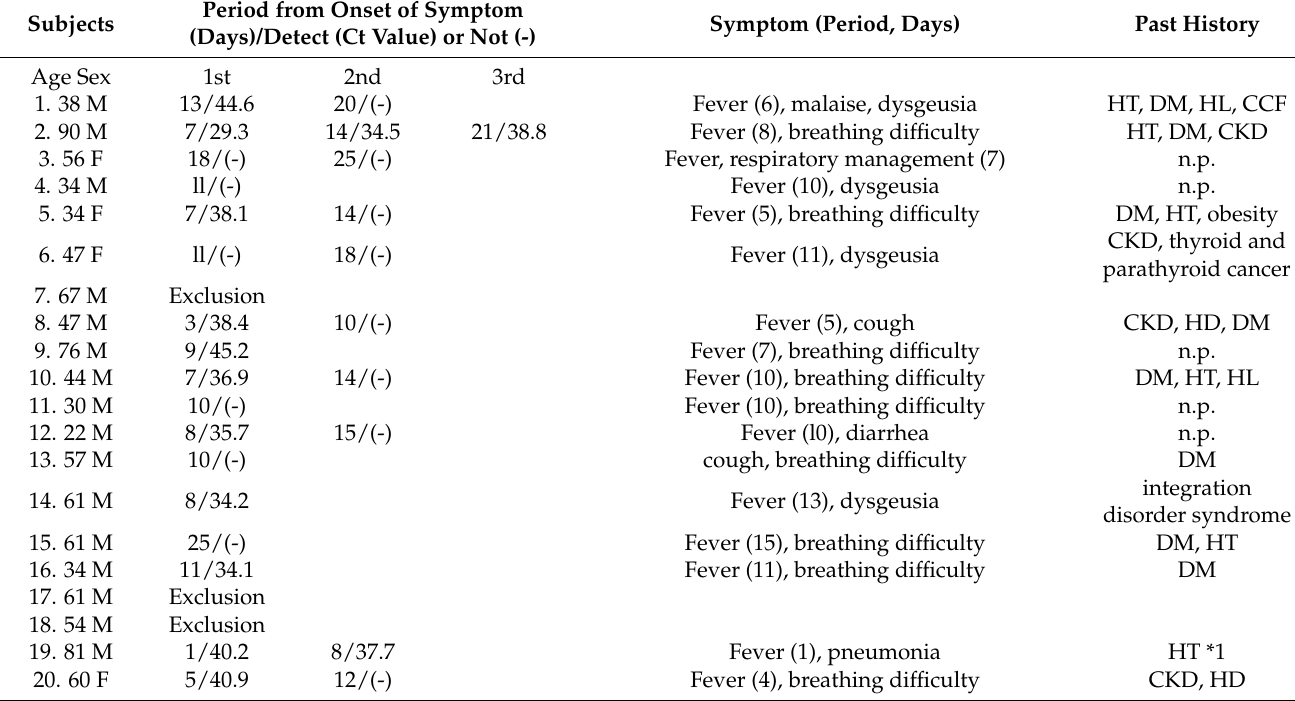
Table 8. Detection of SARS-CoV-2 viral RNA (CDC Nl) in COVID-19 patients by